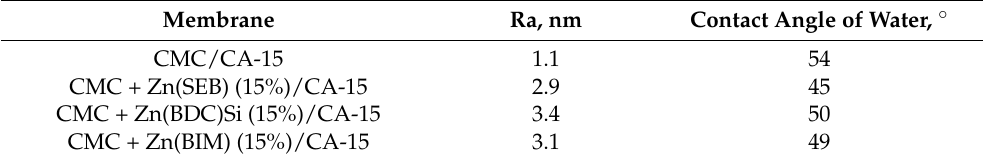
Table 2. The average surface roughness and contact angle for the developed supported cross-linked CMC-based membranes. Membrane Ra, nm Contact Angle of Water,